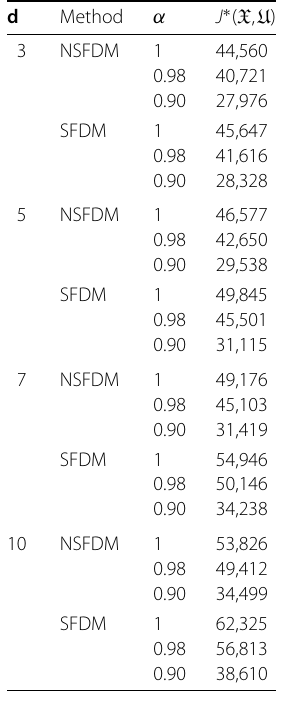
Table 5 Comparisons between the value of objective function J ∗ ( X , U ) using NSFDM and SFDM when 0 ≤ u 1 ≤ 0.8, 0 ≤ u 2 ≤ 0.5, at different time delay d and different α with (cid:7) t = 1, T f =